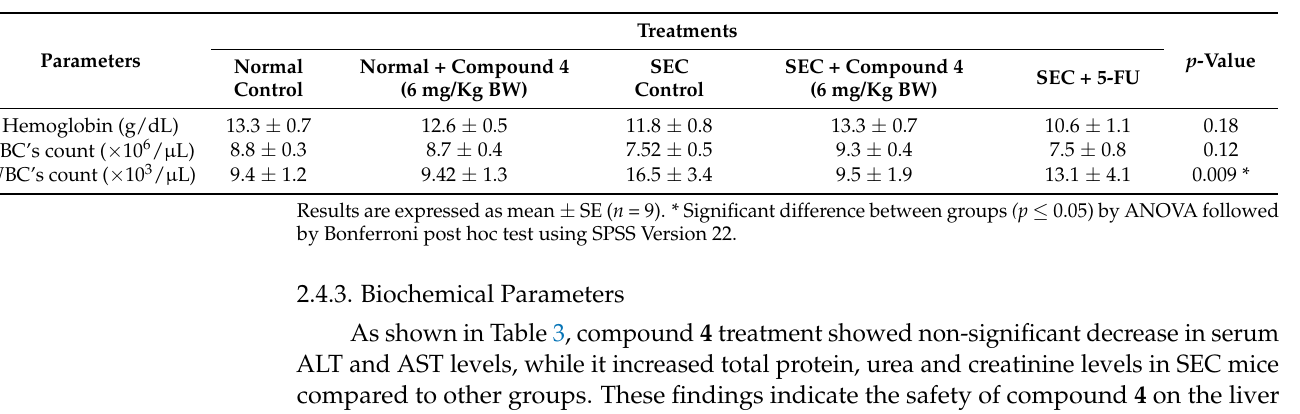
Figure 7. Tumor volume (mm3) and inhibition ratio (%) in SEC-bearing mice treated with a dose of 6 mg/kg of compound 4 and 5-FU. * Significant difference between control and treated groups using ANOVA ( p ≤ 0.05) using SPSS Version 22. Table 2. Effects of compound 4 and 5-FU treatments on the hematological parameters of SEC-bearing mice.